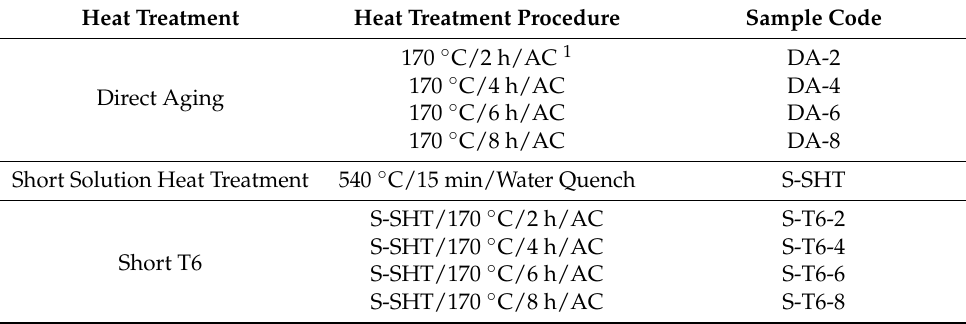
Table 2. Details of the investigated heat treatments and sample codes. 1 AC = Air Cooling .